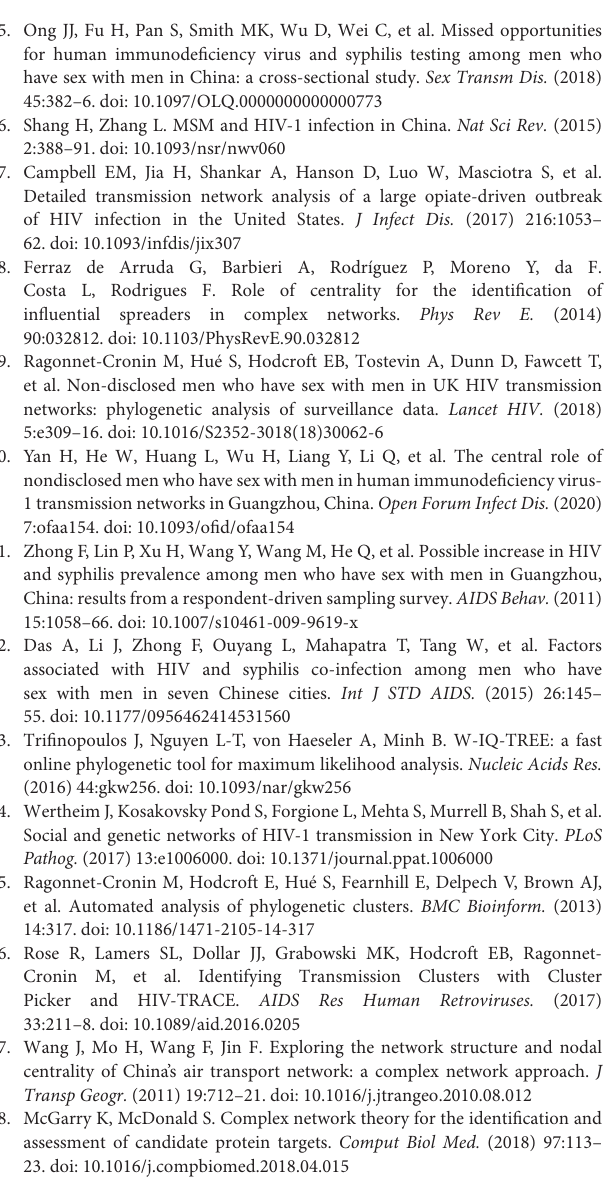
testing, respectively. The chart shows the coverage of syphilis testing among HIV-1 infected MSM clustered in 4 different cluster sizes. The blue and gray bar represent the proportion of HIV-1 infected MSM with and without syphilis testing in the corresponding clusters, respectively. MSM, men who have sex with men; HIV, human immunodeficiency virus. Supplementary Figure 3 | Phylogenetic transmission clusters for HIV-1 infected MSM in Guangzhou, China during 2008 and 2012. Phylogenetic HIV-1 transmission clusters identified by Cluster Picker. The outside circle displayed HIV-1 genotypes with different colors, i.e., HIV-1 CRF55_01B (yellow), CRF 01_AE (blue), CRF07_BC (green), subtype B (purple), and other HIV-1 genotypes (gray). The inside circle showed 46 transmission clusters with colored strips while the non-clustered sequences are displayed as white. Supplementary Figure 4 | Forest plot of the hazard ratio for the factors associated with antiretroviral initiation according to the disclosure of STIs history from 2008 to 2012 in Guangzhou, China. The forest plots summarize the hazard